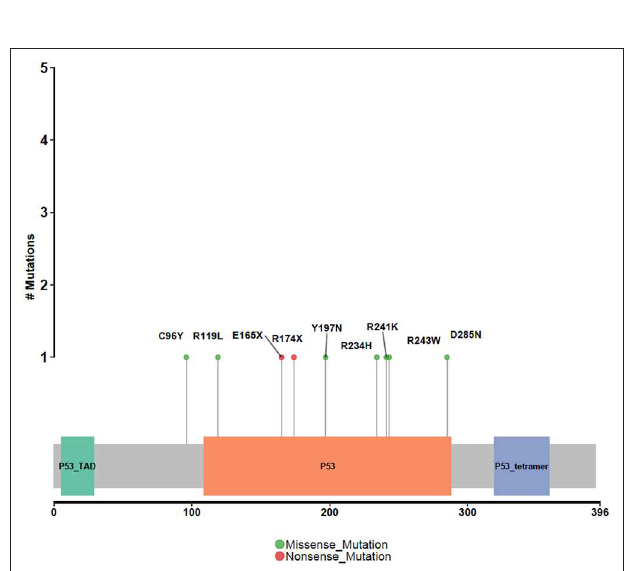
FIGURE 5 | Protein variants resulted from TP53 mutations. Protein variants caused by TP53 mutations are displayed in the lollipop plot. These sites are considered to be mutational